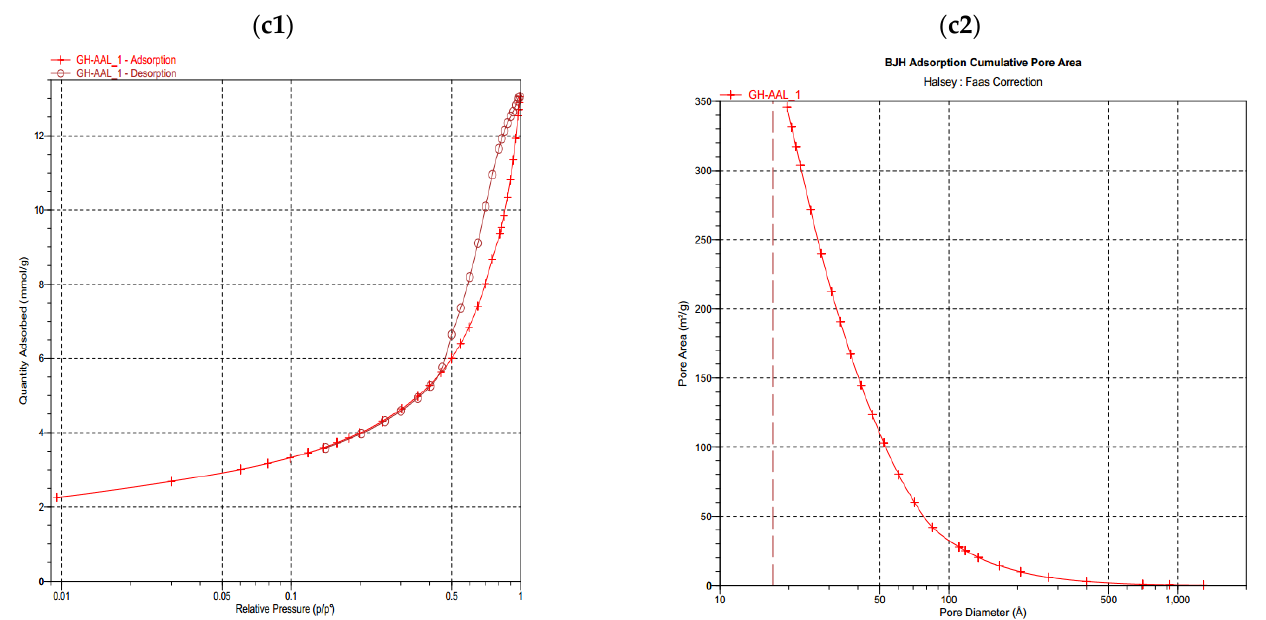
Figure 3. BET analysis: ( 1 ) adsorption/desorption curve and ( 2 ) cumulative pore area curves for natural zeolite ( a ), activated carbon ( b ), and activated alumina ( c ). Table 3. Specific surface area, average pore diameter, and specific pore volume of adsorbents. Parameter Natural Zeolite Activated Carbon Activated Alumina Specific pore volume (cm 3 /g) 0.098 0.128 0.48 Average pore diameter (nm) 11.7 2 5.3 Specific surface area (m 2 /g) 19.87 897.5